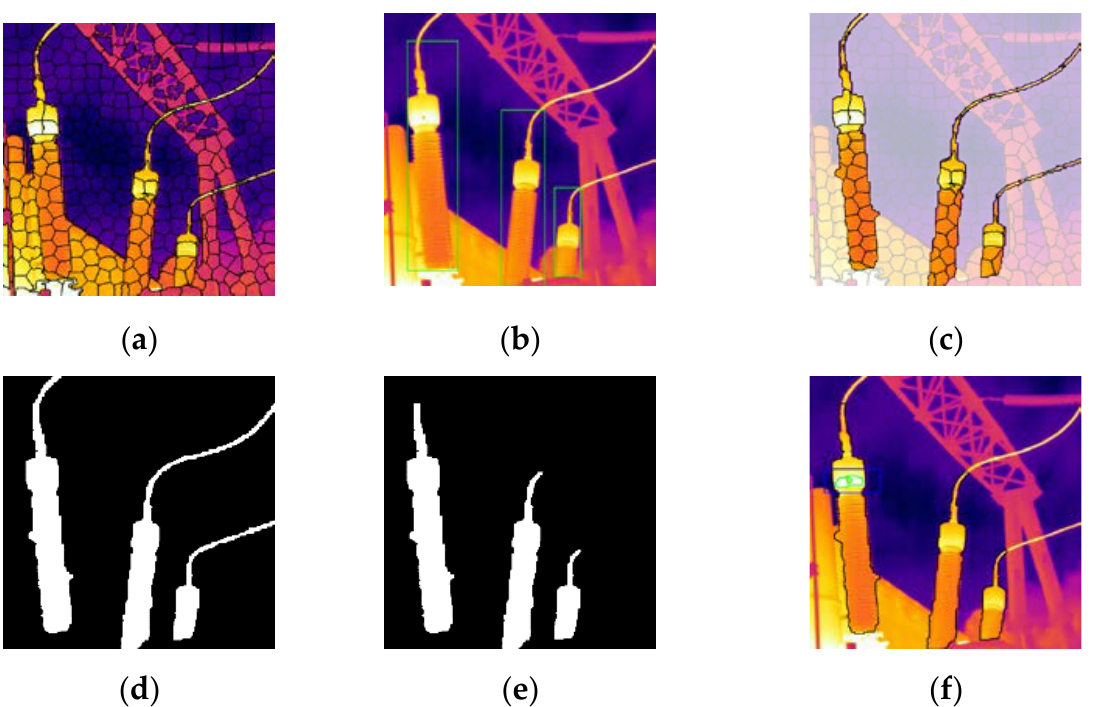
Figure 12. The results of each step in the process of diagnosis by our method ( a ) Super pixel segmentation ( b ) Image recognition ( c ) Super pixel binning ( d ) Image segmentation ( e ) Area to be inspected ( f ) Diagnosis result.